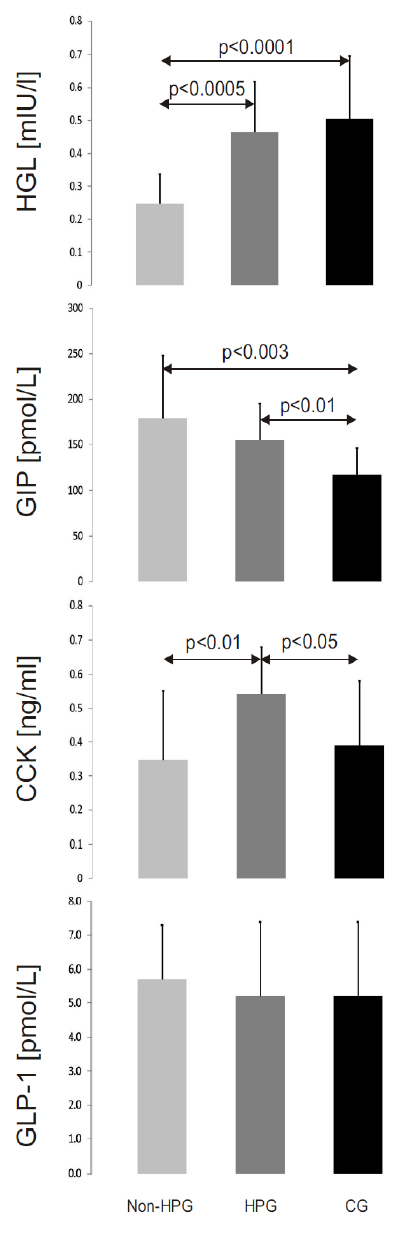
Figure 1. The mean activity of human gastric lipase (HGL) and mean concentrations of cholecystokinin (CCK), glucagon-like peptide-1 (GLP-1) and